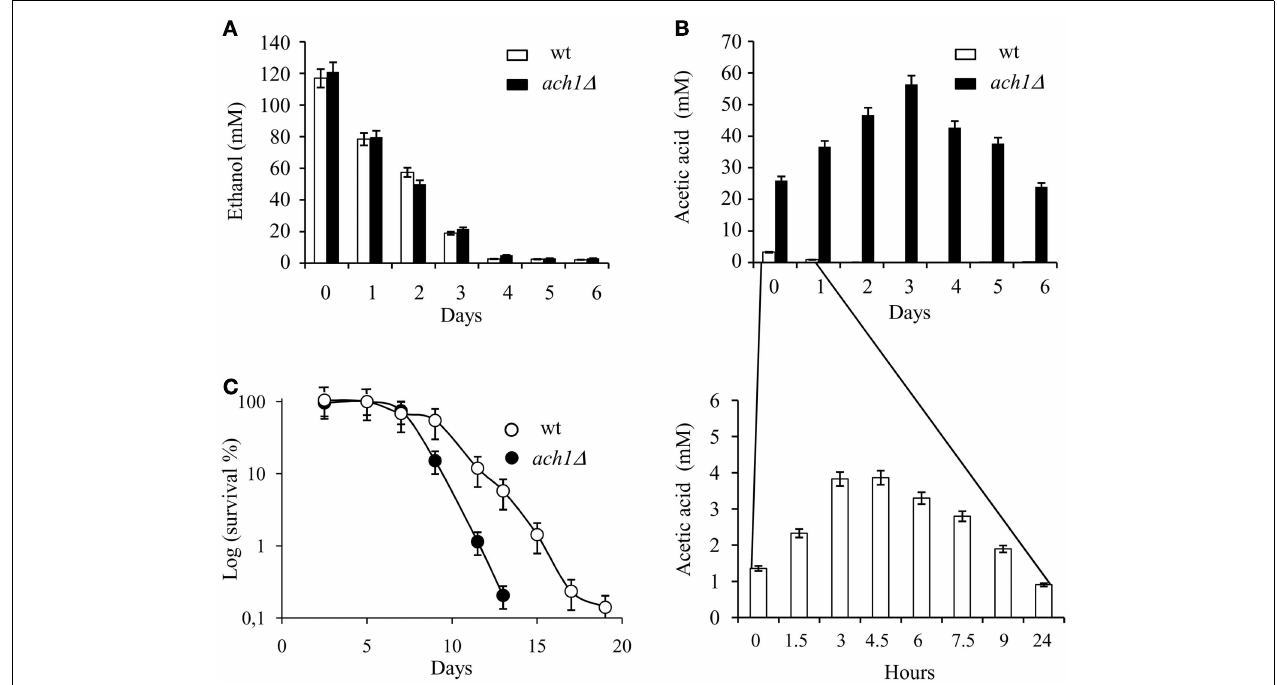
Day 0, diauxic shift. Inset: time-scale blow-up. Error bars are the standard deviation of three replicates. (C) CLS of wt and ach1 ∆ mutant cells. At every time-point, viability was determined by counting CFUs onYEPD plates. 72h after the diauxic shift (Day 3), was considered the first age-point (see Materials and Methods). Error bars are the standard deviation of three